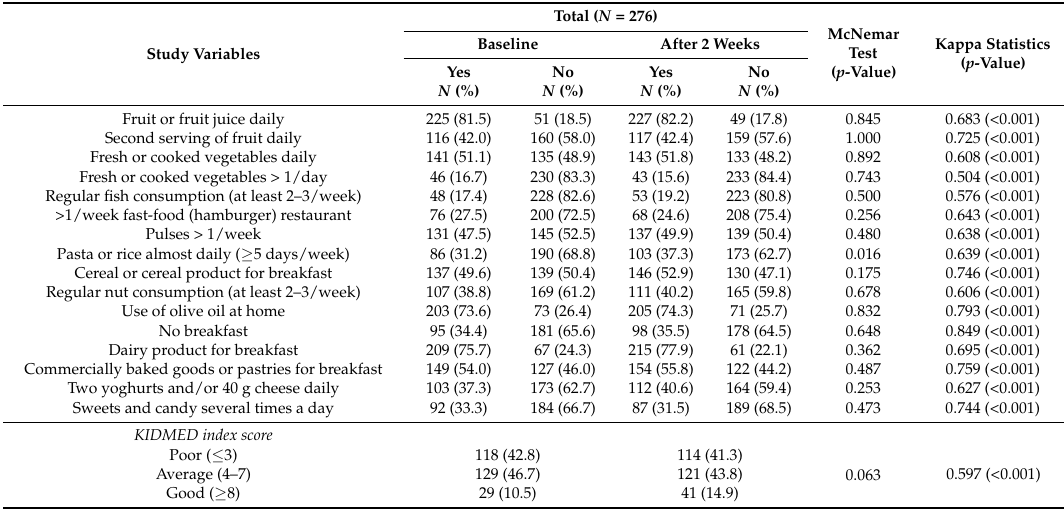
Table 2. Mediterranean Diet Quality Index statistics for total sample ( N =